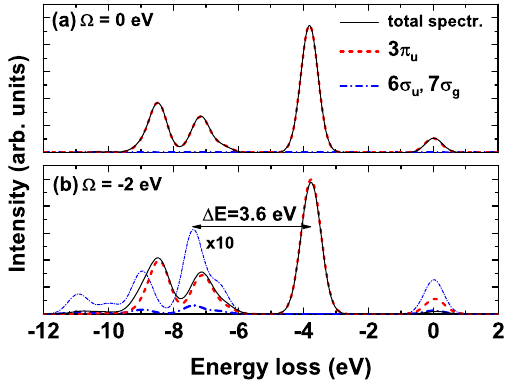
FIG. 6. Partial S K β RIXS cross sections σ μ ð ω ; ω 0 Þ [see Eq. (9)] of the CS 2 molecule corresponding to the scattering through the the total RIXS spectrum including multielectron and interference effects is shown as the black solid line. The calculations are performed for the excitation-energy detuning from the 1 s → 3 π LUMO resonance: (a) Ω ¼ 0 and (b) Ω ¼ − 2 eV. The thin curve = 7 σ shows the j 1 s − 1 6 σ partial contribution with intensity u g i multiplied by 10 for visibility. The partial emission profiles σ emis and σ emis 6 σ are shifted by Δ E ≈ 3 . 6 eV, the energy spacing 3 π 7 σ u u = g between the first two absorption